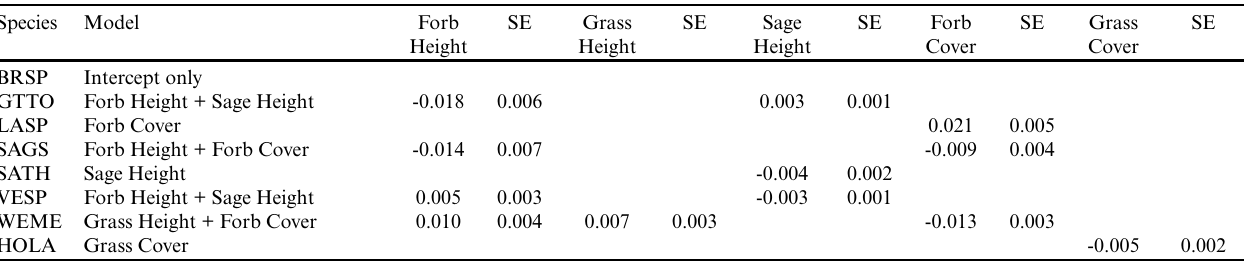
Table 3 . Habitat relationships for eight sagebrush associated songbirds in western Colorado from AIC selected best models of density for each species. Percent grass cover was not included in any of the best models and is therefore not included in the table. Bird species are Brewer’s Sparrow ( Spizella breweri, BRSP), Green-tailed Towhee ( Pipilo chlorurus, GTTO), Horned Lark ( Eremophila alpestris , HOLA), Lark Sparrow ( Chondestes grammacus, LASP), Sage Sparrow ( Amphispiza belli, SAGS), Sage Thrasher ( Oreoscoptes montanus, SATH), Vesper Sparrow ( Pooecetes gramineus, VESP), and Western Meadowlark ( Sturnella neglecta,